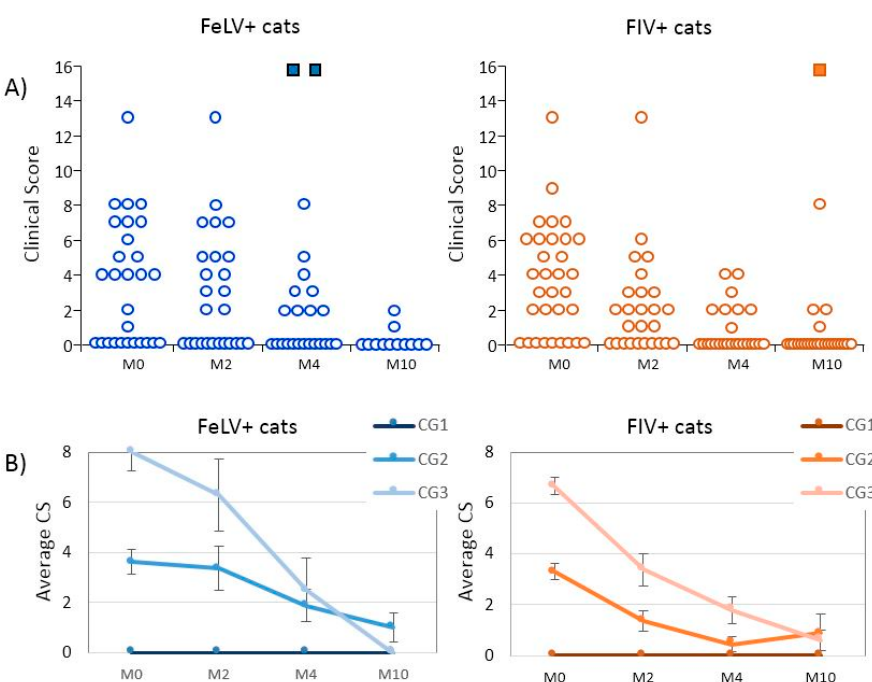
Figure 1. Evolution of the clinical score (CS) of the cats during the study. ( A ) General representation of the evolution. Each circle represents a cat analyzed, and each square a dead cat. ( B ) General trend of the average CS of the three clinical groups (CG) in which the cats were classified. Bars indicate standard error. M0, beginning of treatment; M2, two months (±15 days) after beginning of treatment (mid-treatment); M4, four months (±15 days) after beginning of treatment (end of treatment); M10, 10 months (±2 months) after beginning of treatment. CG1, asymptomatic cats; CG2, cats with mild disease; CG3, cats with severe disease.